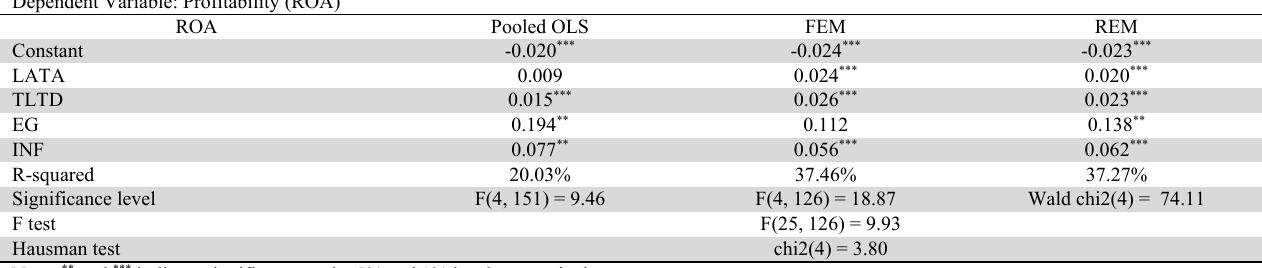
Results of testing the model using Pooled OLS, FEM, REM Dependent Variable: Profitability (ROA) ROA Pooled